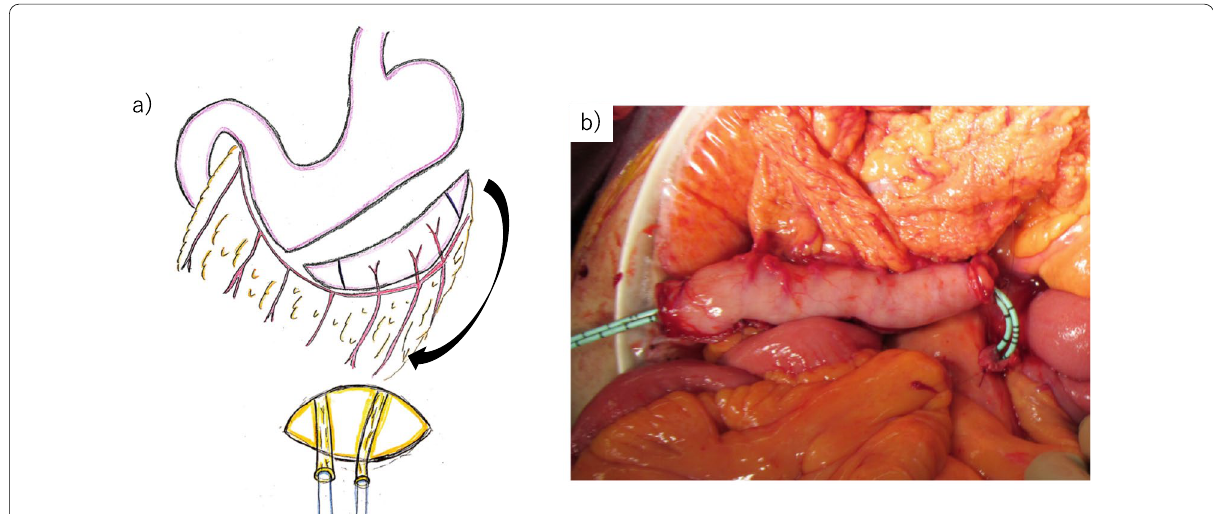
Table 1 Crohn’s disease-related anorectal cancer requiring combined resection of adjacent organs in our institution Sex Age (years) Type of Combined operation